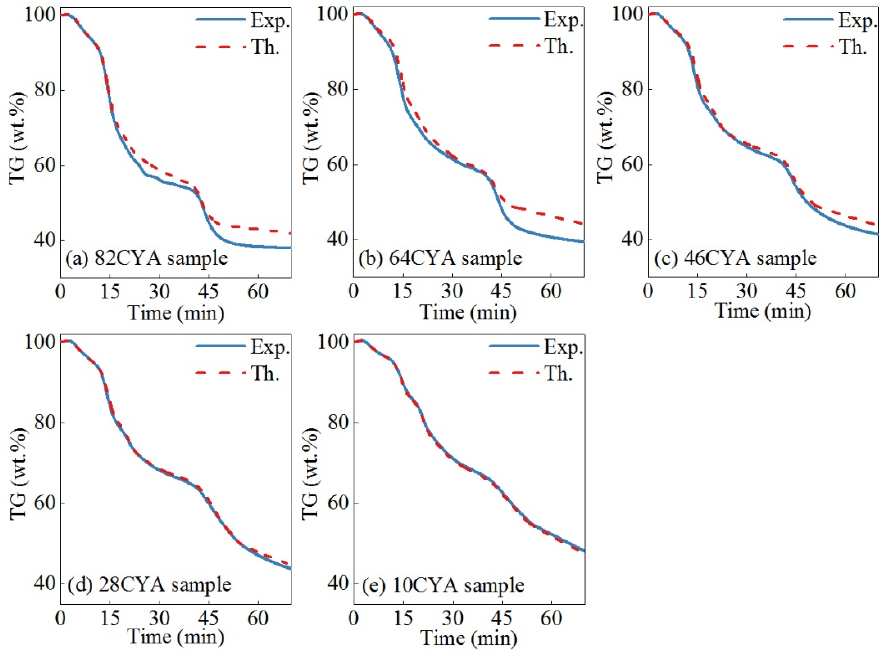
Table 2. The interaction index MR of the pyrolysis and gasification process.